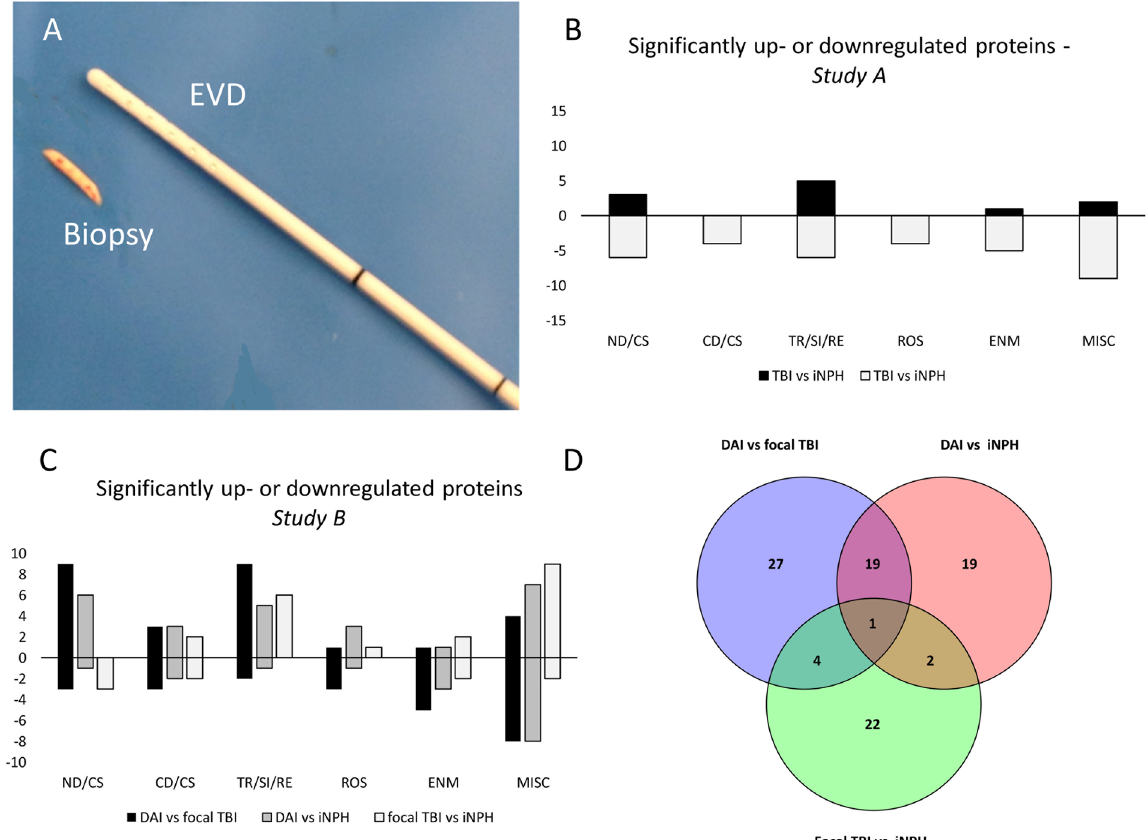
Figure 1. ( A ) Tissue biopsy, obtained with a biopsy needle with 14 gauge, 2.11 mm outer diameter and an 8 mm side cutting window (Elekta Instrument AB, Innsbruck, Austria), to be compared with external ventricular drain (outer diameter 2.5 mm) placed into the same cortical area at site of biopsy. ( B ) Diagram demonstrating differentially expressed proteins in patients with severe traumatic brain injury (TBI) when compared to patients with idiopathic normal pressure hydrocephalus (iNPH) ( Study A ). Positive values represent upregulated proteins. Negative values represent downregulated proteins. For a detailed list of differentially expressed proteins see Table 3. ( C ) Diagram demonstrating number of differentially expressed proteins among groups in different cellular mechanisms in Study B . Positive values represent upregulated proteins. Negative values represent downregulated proteins. For a detailed list of differentially expressed proteins see Tables 4–6. ( D ) Venn diagram demonstrating overlap in differentially expressed proteins in the analysis of diffuse axonal injury (DAI) vs focal TBI, DAI vs iNPH and focal TBI vs iNPH. For a detailed list of differentially expressed proteins with overlap see Suppl. Table 2. EVD = external ventricular drainage, TBI = traumatic brain injury, iNPH = idiopathic normal pressure hydrocephalus, DAI = diffuse axonal injury, ND/CS = neurodegeneration/ cytoskeletal, CD/CS = cell death/cell survival, TR/SI/RE = transport/signaling/repair, ROS = reactive oxygen species, ENM = energy metabolism, MISC =